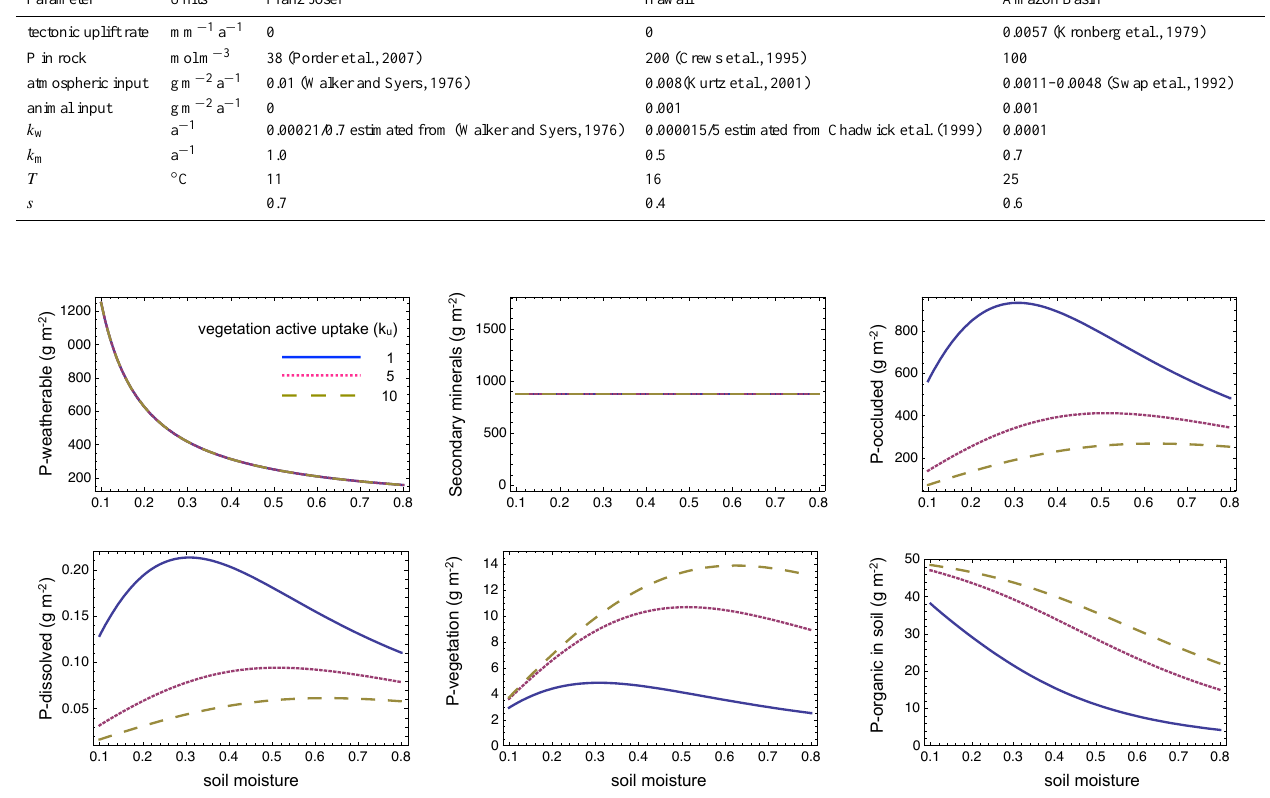
Fig. 4. Active P vegetation uptake ( k u ) sensitivity to soil moisture. To compare the result of the symbiotic relationship within ecosystems we simulated ecosystems with different uptake rates: the dashed lines represent no symbiosis ( k u =1), the solid lines represent strong symbiosis ( k u =10), and the dotted lines represent intermediate symbiosis ( k u =5). For these simulations, we used the steady-state solution (Eqs. 18–23). For the parameters used refer to Table 2 and to the system input parameters for the Amazon Basin in Table